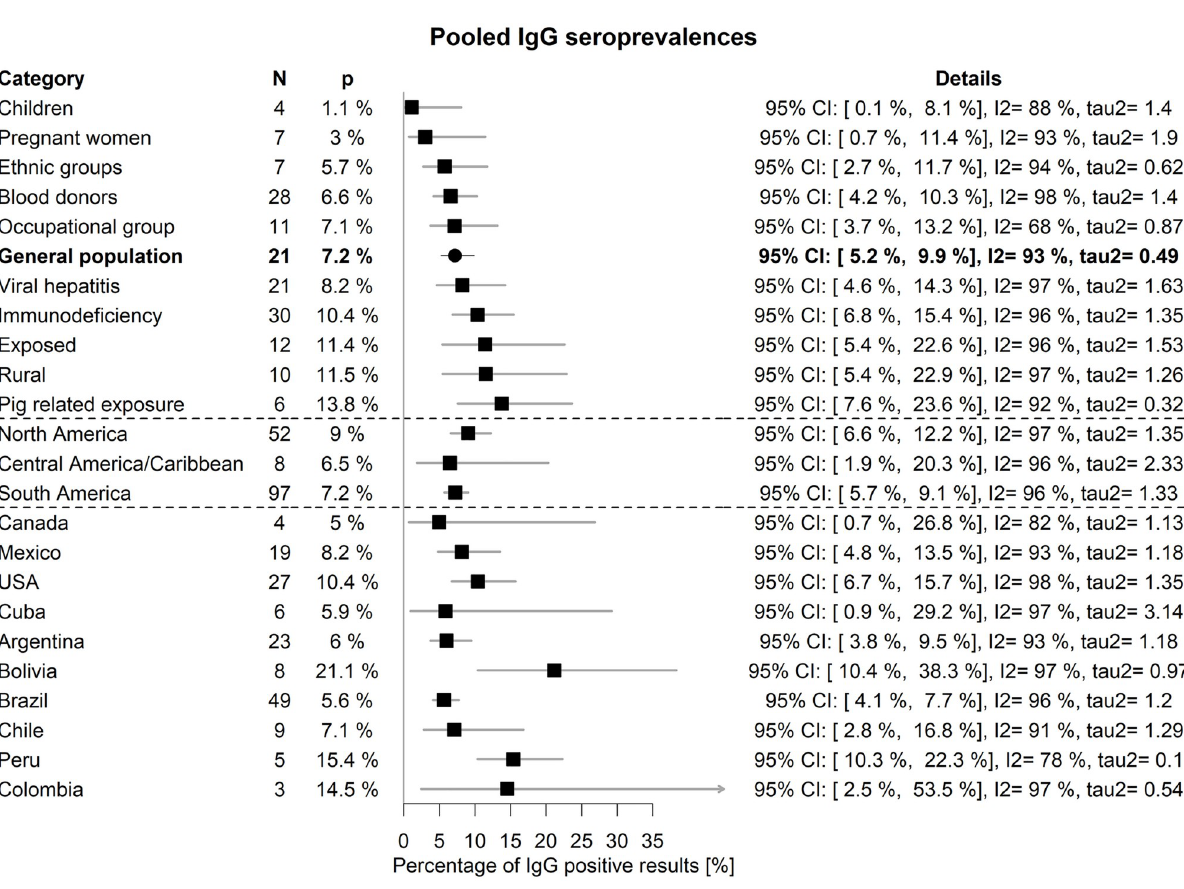
Fig 2. Overview of pooled IgG seroprevalences obtained from random-effects GLMM with 95% confidence intervals constructed using t- quantiles. N denotes the number of published results underlying the pooling. Further details behind the pooled numbers can be seen in pages 66–73 in S1 File. The very large heterogeneity among the results from Cuba is due to one study reporting a large seroprevalence of 71% for a sample of outbreak and sporadic acute cases of viral hepatitis. Without this result, the pooled estimates would change as follows: 3.0%, 95% CI: 1.0%–8.4%, I 2 = 94%, tau2 = 0.66 (Cuba) and 4.2%, 95% CI: 1.9%– 9.0%, I 2 = 93%, tau 2 = 0.70 (Central